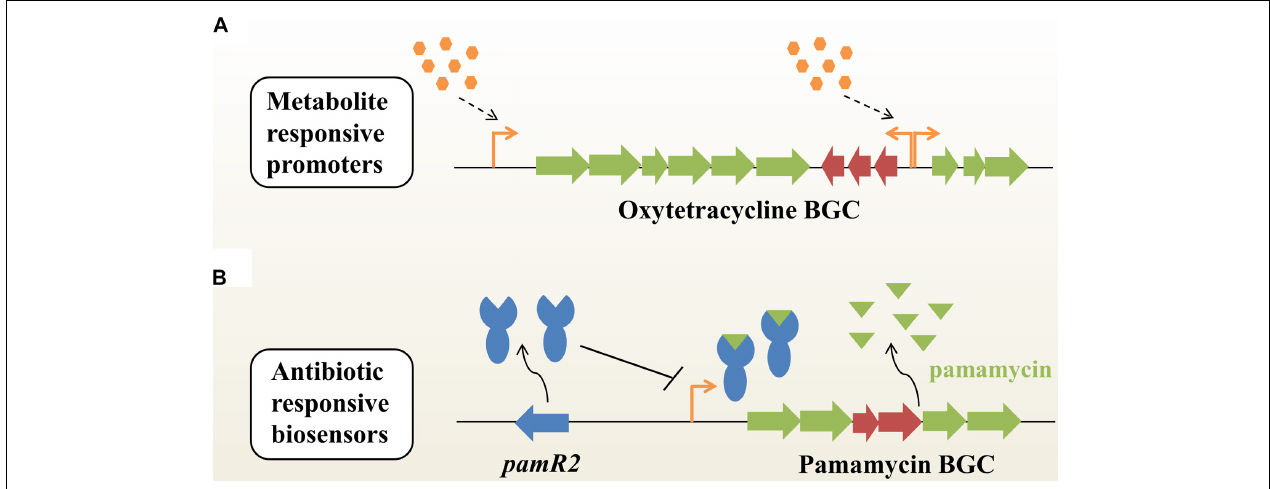
FIGURE 1 | Dynamic pathway regulation balances flux between bacterial growth and antibiotic biosynthesis in actinobacteria. (A) Autoregulated fine-tuning of the expression of an antibiotic (e.g., oxytetracycline) BGC based on metabolite-responsive native promoters without specific transcription factors or additional inducers. BGC, biosynthetic gene cluster. (B) Antibiotic-responsive biosensors. This strategy is engineered from cluster-situated regulators (e.g., PamR2) that bind to their associated promoters upon interaction with the corresponding secondary metabolites (e.g., pamamycins). Placing antibiotic biosynthetic genes under such promoters enables antibiotic dependent gene expression.